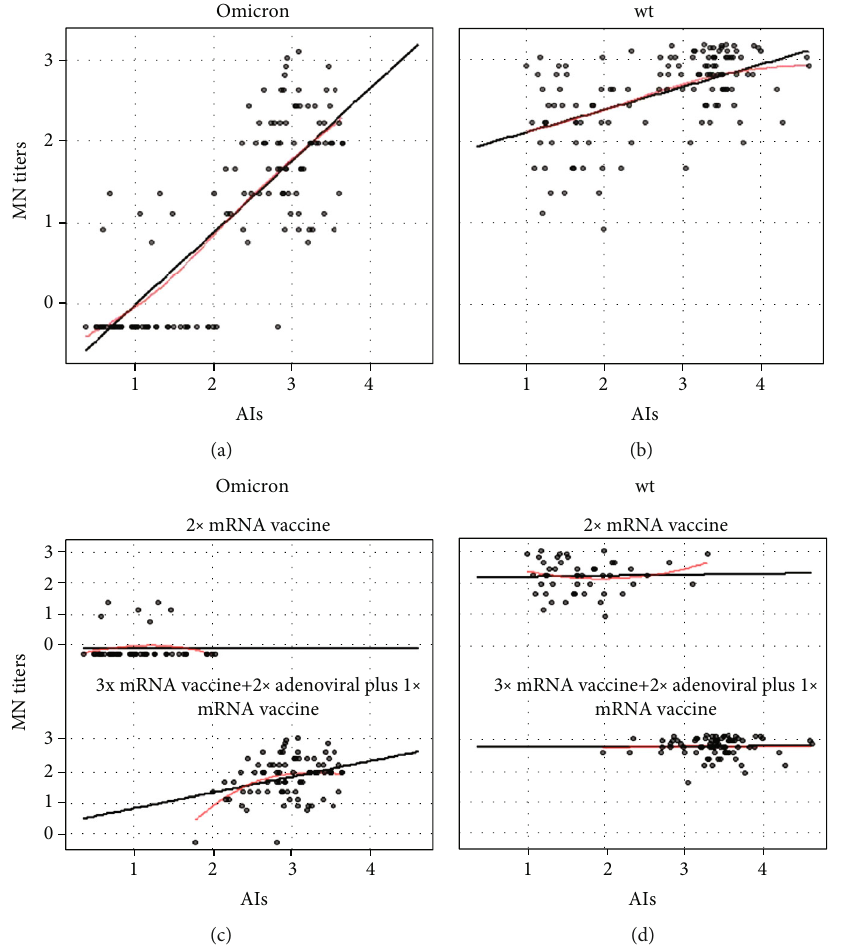
Figure 3: Multiple regression model of antibody avidity and neutralizing antibody titres. Microneutralization (MN) titers are expressed as log2 of the normalized data. Antibody avidity results are expressed as normalized data of avidity index (AI). Regression of MN titers on AI with the virus strain as the dummy variable, Omicron variant (a), and wt virus (b) proved signi fi cant for both strains. The number of vaccine doses was included in the regression analysis as a variable: 2 vaccine doses in the top panels, 3 doses in the bottom panels of the Omicron variant (c) and wt virus